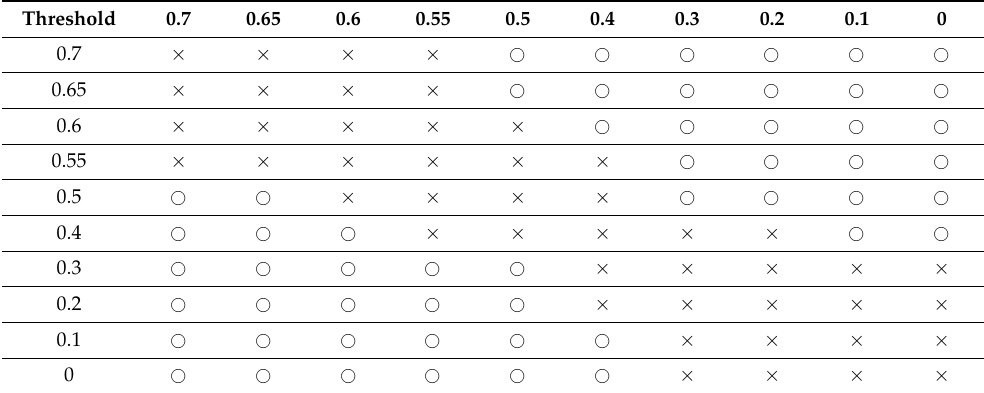
Table 2. The result when MME is taken based on the different threshold of KGE. Also, it shows the differences for KGE in the validation period.